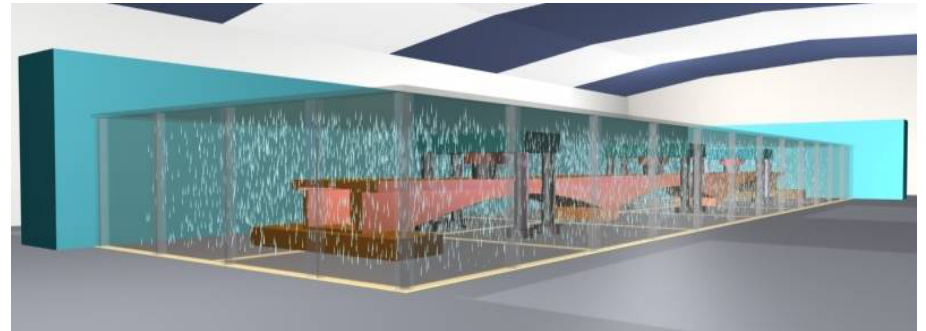
Figure 9. The artificial acceleration test of bridge under combined environment and